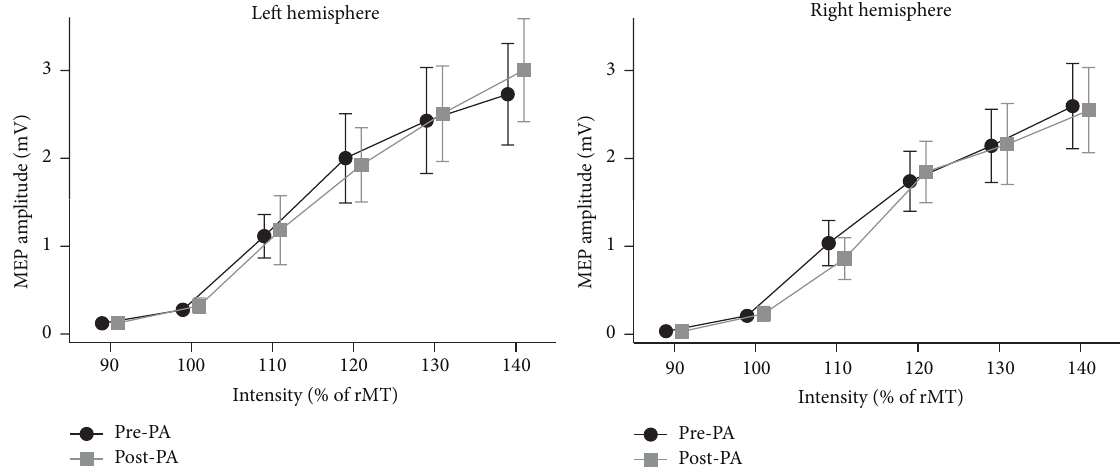
Figure 4: Input/output curve plots of average MEP amplitude across all subjects in Experiment 2 for both hemispheres ( 𝑛 = 10 ). MEP amplitude ( 𝑦 -axis) is represented in mV and error bars represent standard errors of the mean